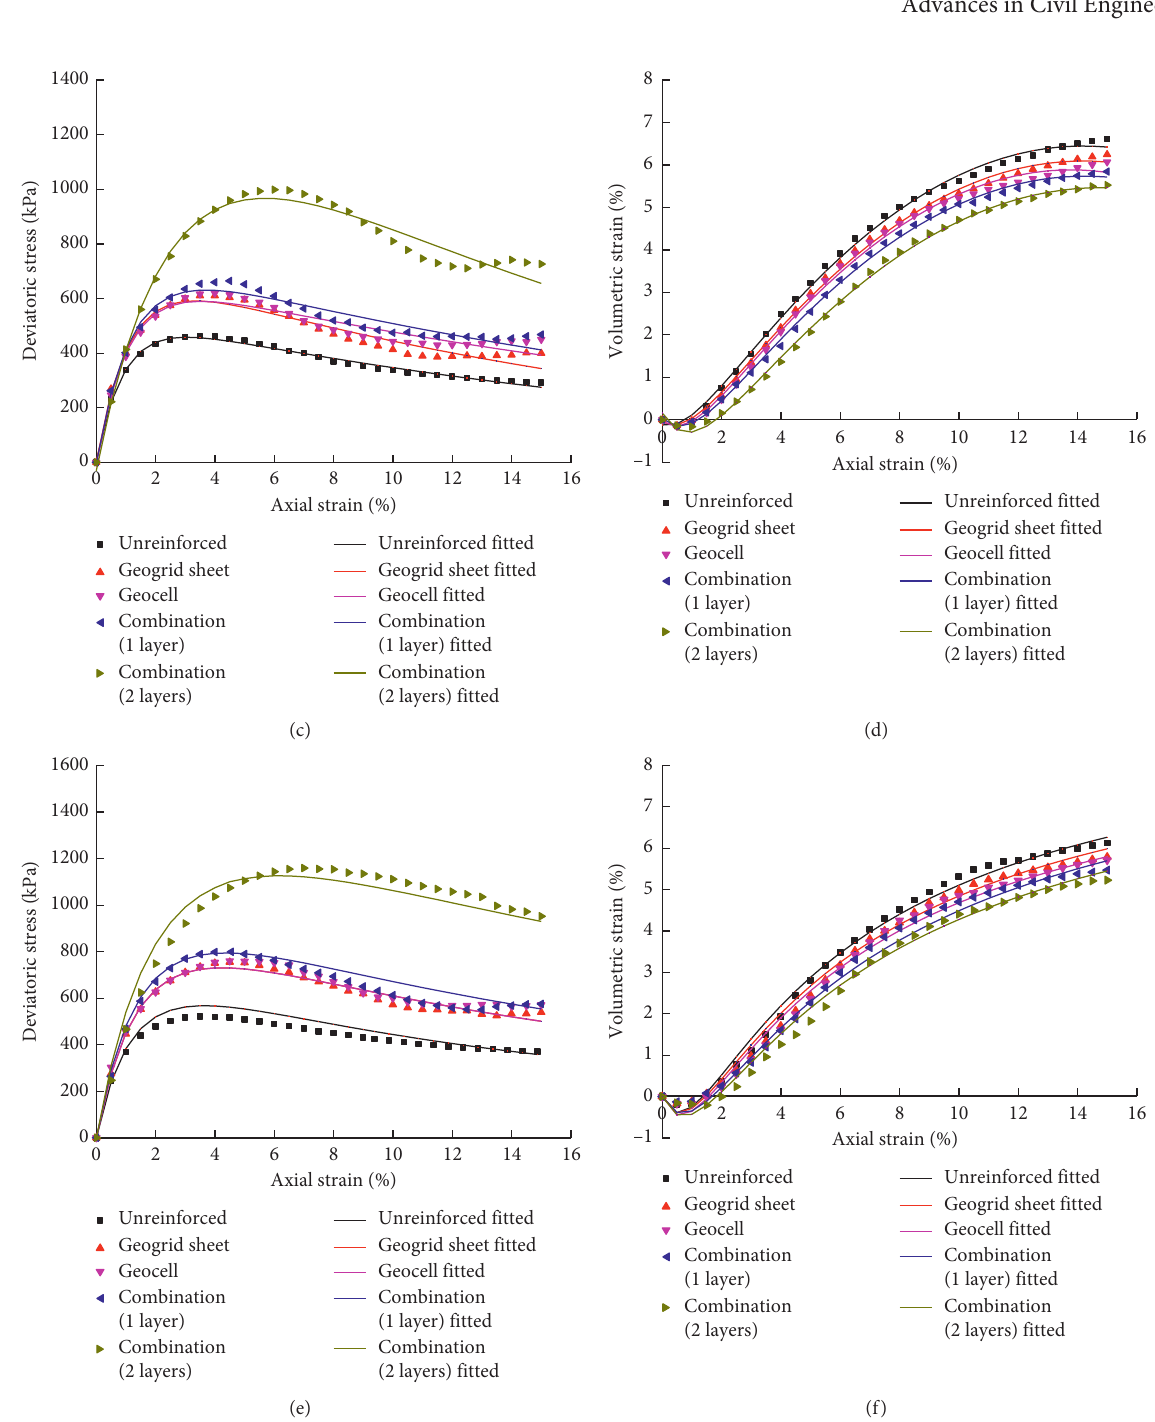
− σ ) and ε / ( σ v / ε 1 relationship: (a) σ 3 1 1 3